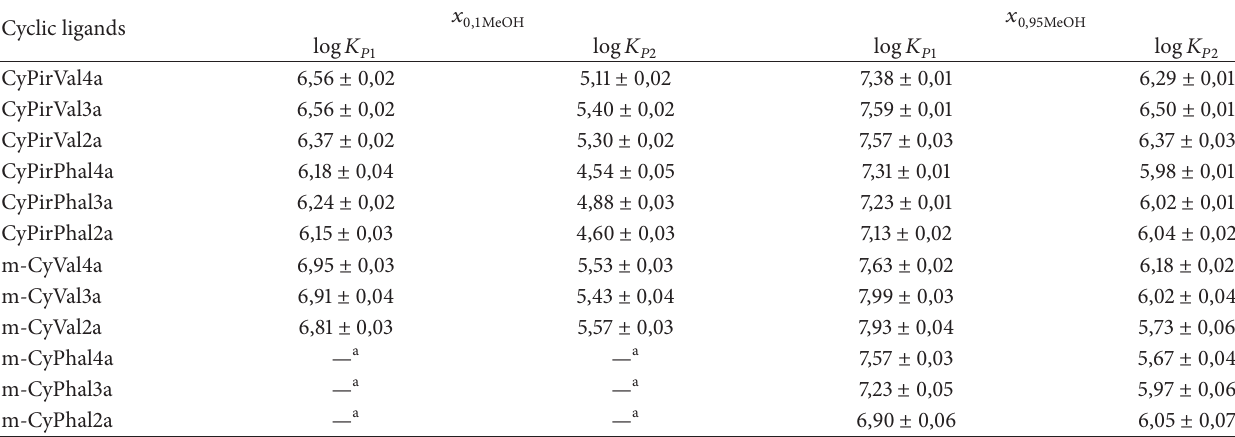
Table 2: Logarithm values of successive protonation constants CyPirVal( 𝑛 )a, CyPirPhal( 𝑛 )a, m-CyVal( 𝑛 )a, and m-CyPhal( 𝑛 )a in methanol- water solution 𝑥 0,1 MeOH and 𝑥 0,95 MeOH .